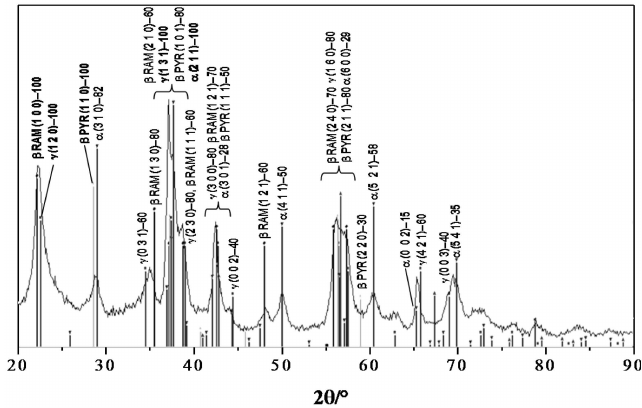
Figure 3. X-ray powder diffraction (XRPD) pattern of the M_hydro sample with the most intense reflections ( hkl , intensity) of the main polymorphs ( γ -MnO 2 nsutite, β -MnO 2 ramsdellite (RAM), β -MnO α -MnO 2 pyrolusite (PYR) and 2 hollandite).